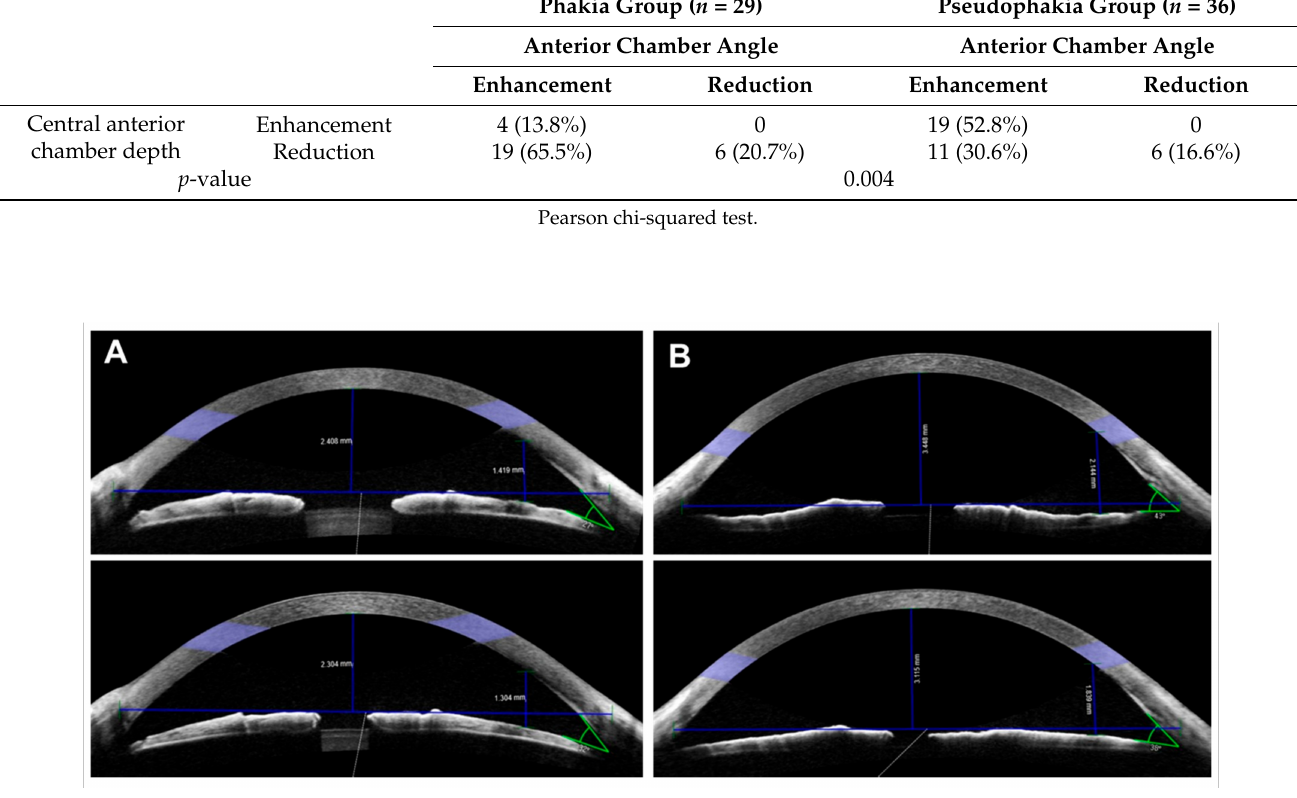
Figure 4. Anterior segment optical coherence tomography (AS-OCT) images of representative patients in the phakia group. Top depicts pre-miotic image and bottom depicts post-miotic image. ( A ) Anterior chamber (AC) angle widened (27 ◦ to 32 ◦ ), but central (CAC) and peripheral anterior chamber (PAC) depths became shallower after miosis (2.408 mm to 2.304 mm and 1.419 mm to 1.304 mm, respectively). ( B ) AC angle (43 ◦ to 36 ◦ ) narrowed and CAC and PAC depths (3.448 to 3.115 mm and 2.144 to 1.839 mm, respectively) became shallower after